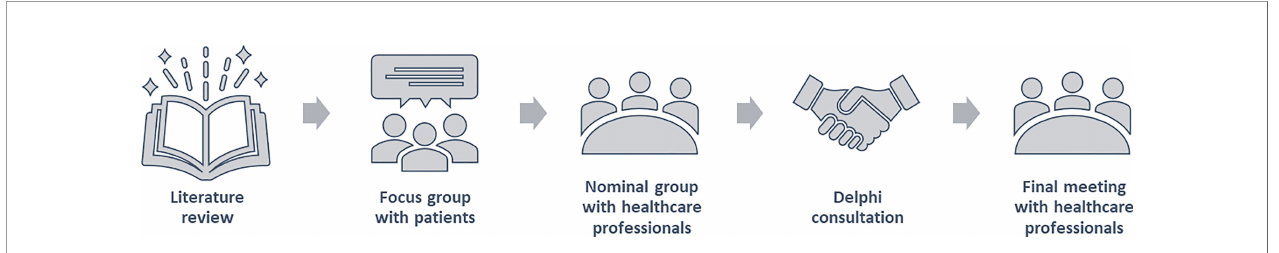
FIGURE 1 | Study fl